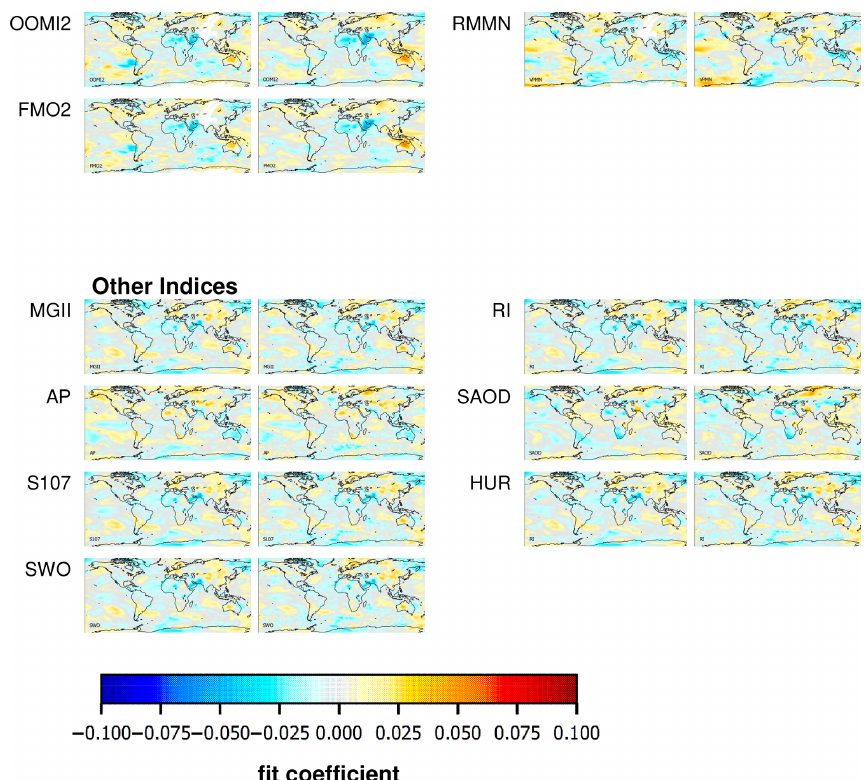
Figure A9. Fit coefficients for all indices used in this study. Shown are the results for the TCWV data set from satellite observations (left) and model results (for all sky conditions)